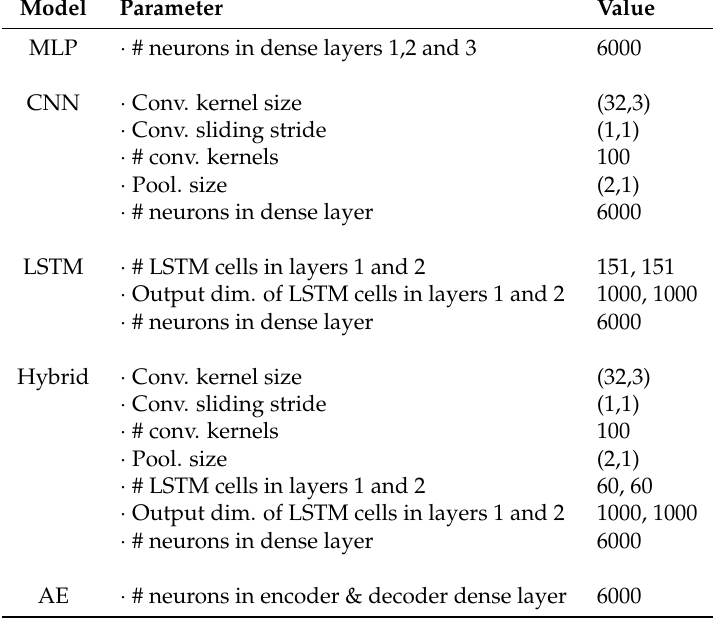
Table 8. Hyper-parameters of the deep-learning-based models on the UniMiB-SHAR dataset. The parameters values are given assuming that the input of the models is of size T × S . Convolutional kernels and pooling sizes are respectively given as ( f in Section